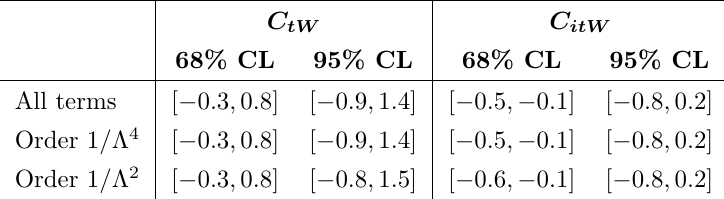
region of interest. If the Lagrangian had not been truncated at dimension six,